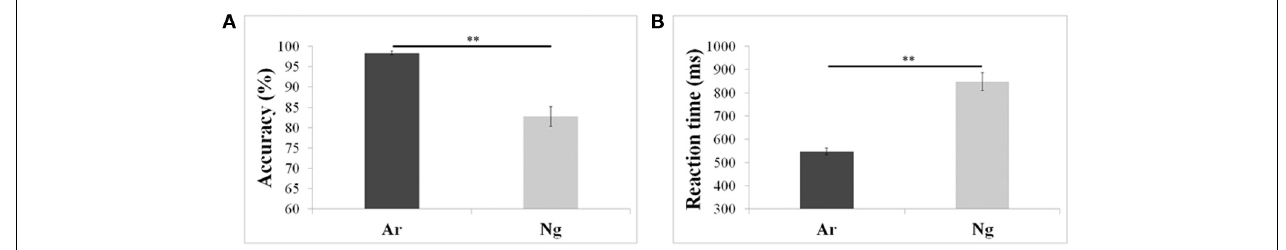
Table 2 | Behavioral performance of the participants.